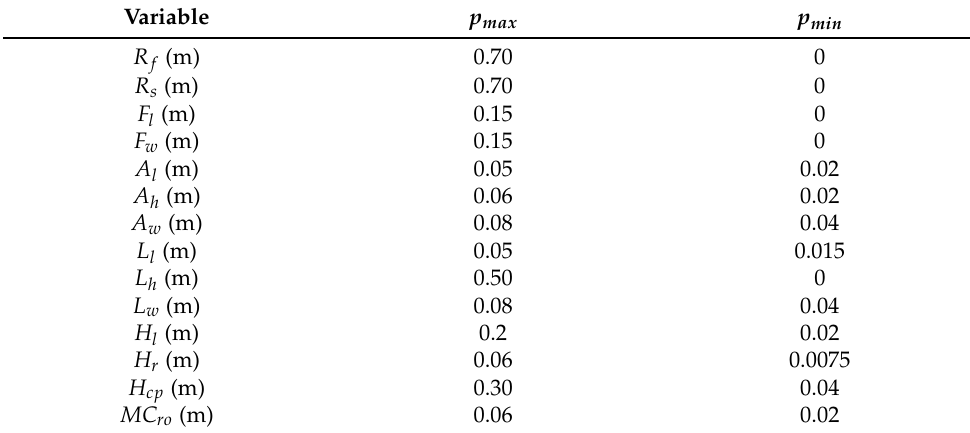
Table 2. Upper and lower bounds of geometric design variables p sg